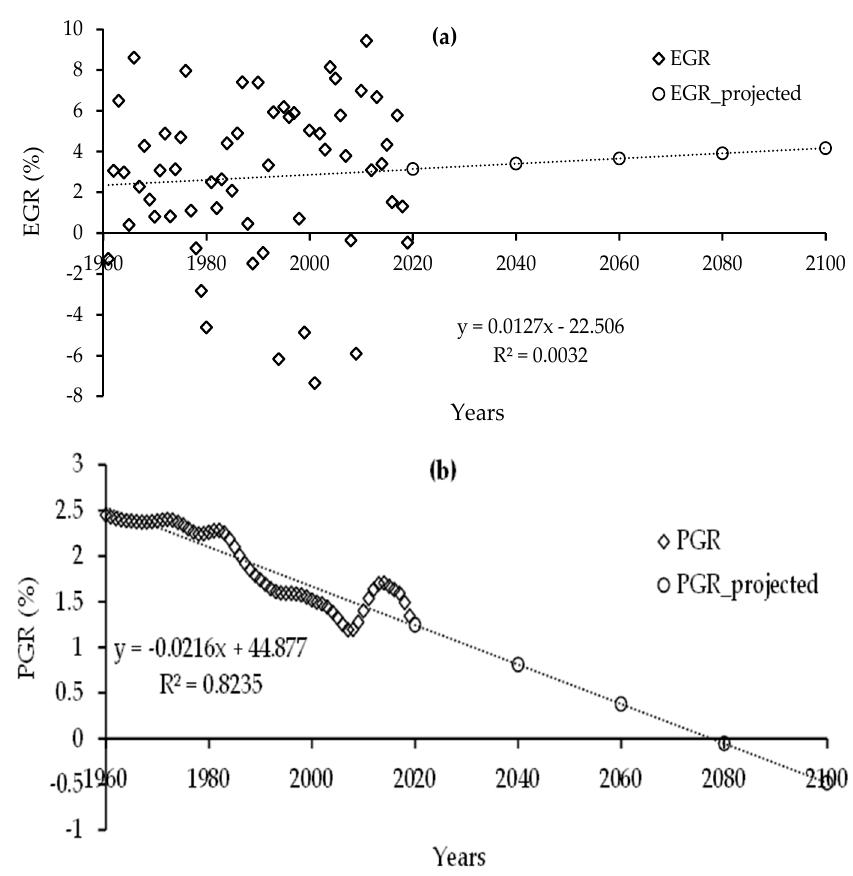
Figure 6. ( a ) Economic Growth Rate and ( b ) Population Growth Rate of Turkey